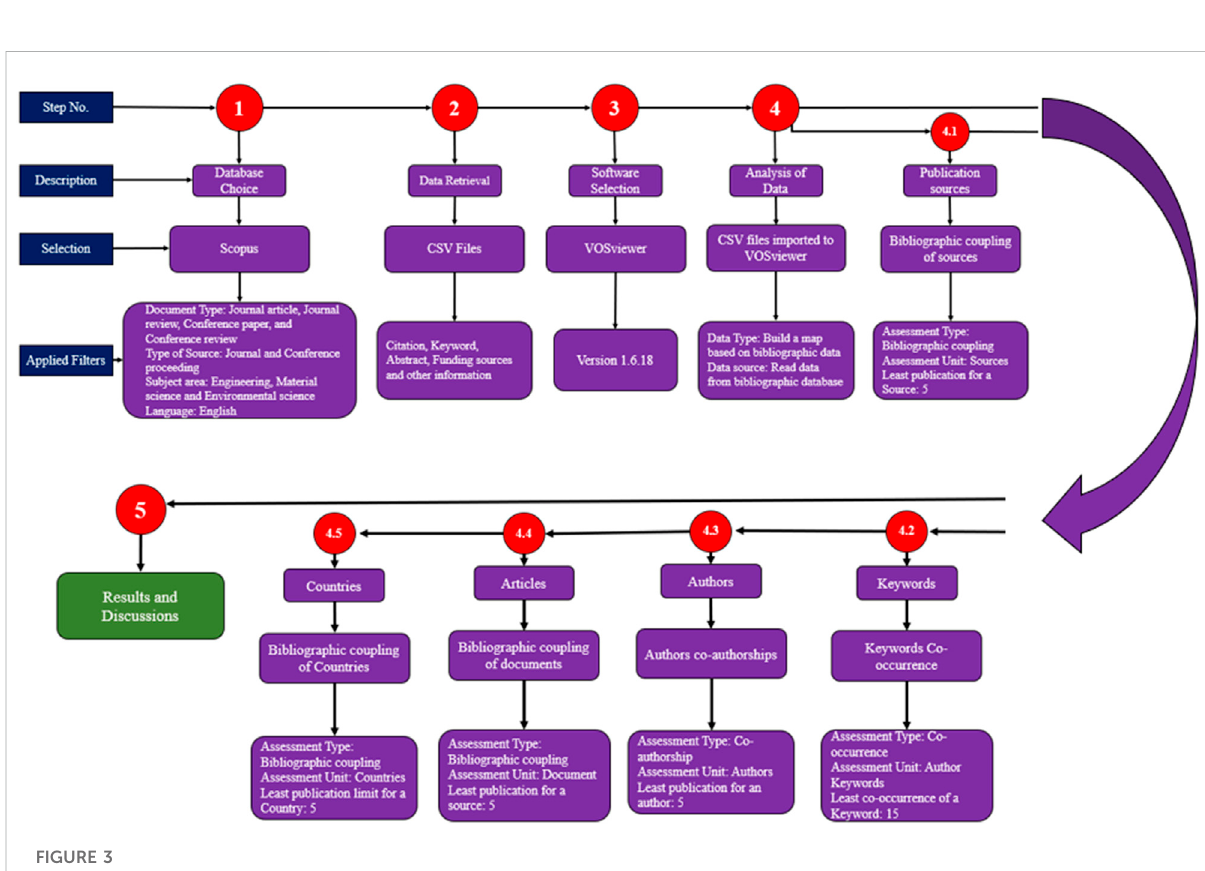
Sequential fl owchart of the review